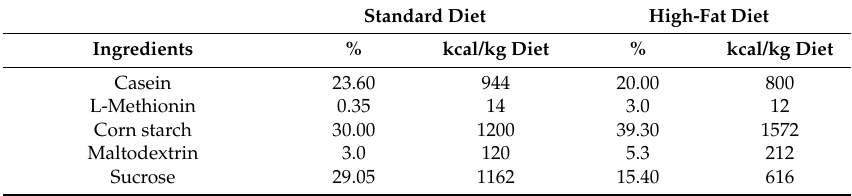
Table 1. Composition of the standard and high fat diet administered for 12 weeks to hamsters.